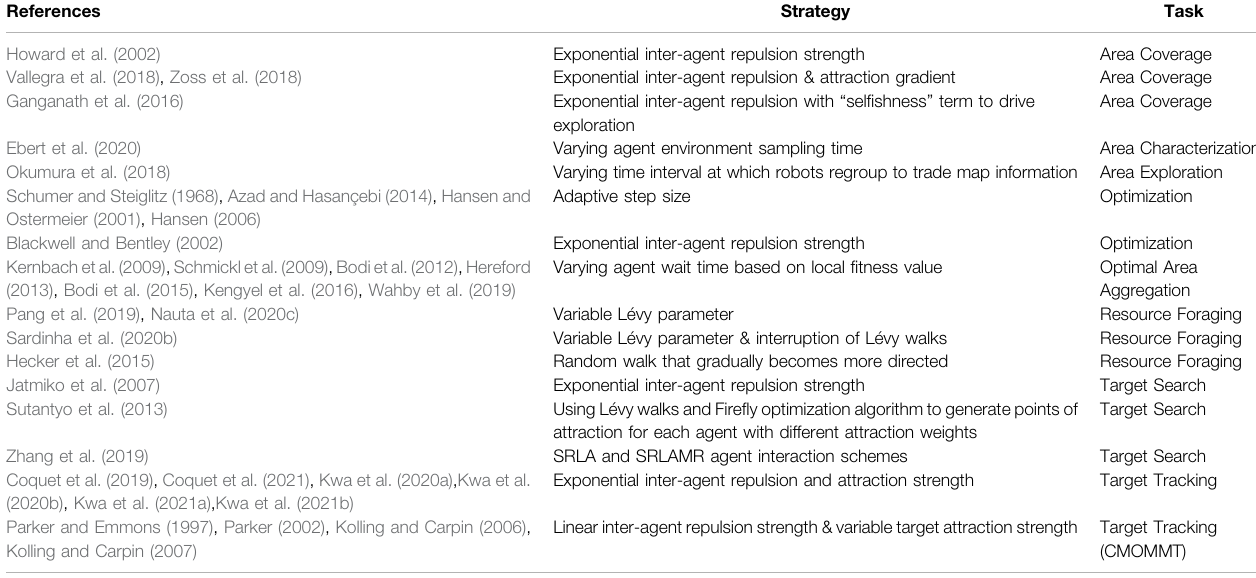
TABLE 6 | List of works using small response changes to in fl uence the level of exploration and exploitation of an MAS.